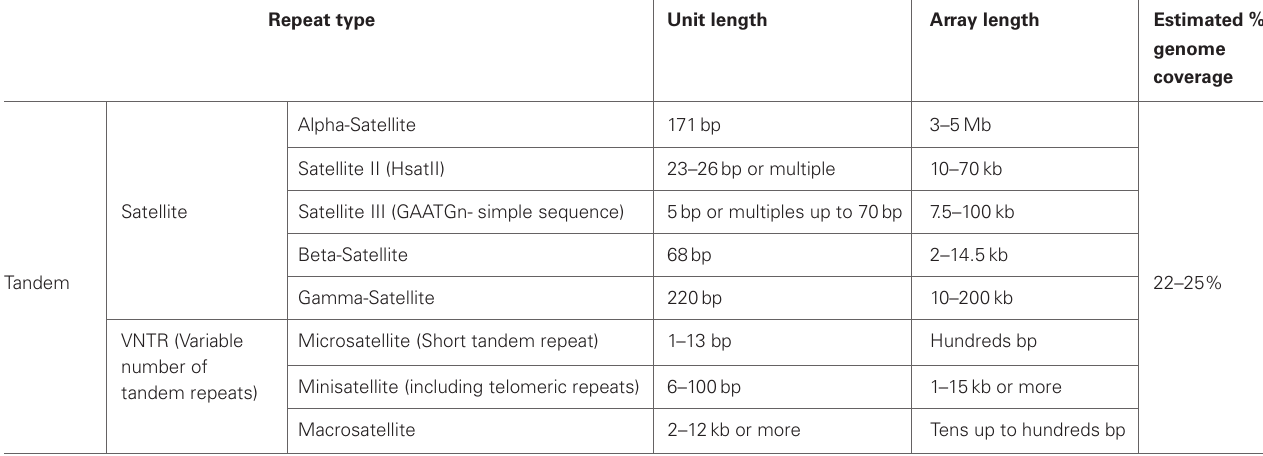
Table 2 | Major features of the most represented tandem repeats in the human